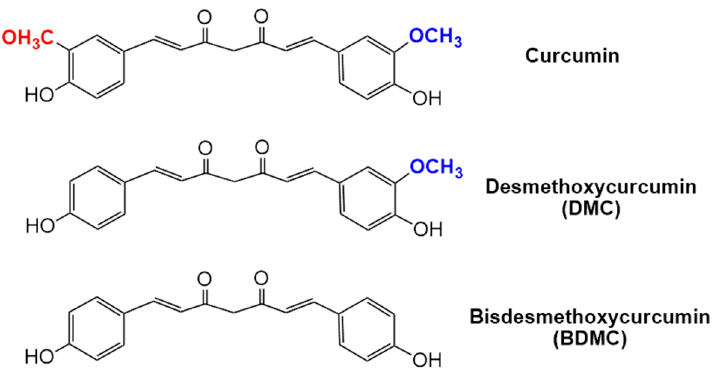
Figure 1. Structure of the three main curcuminoids.